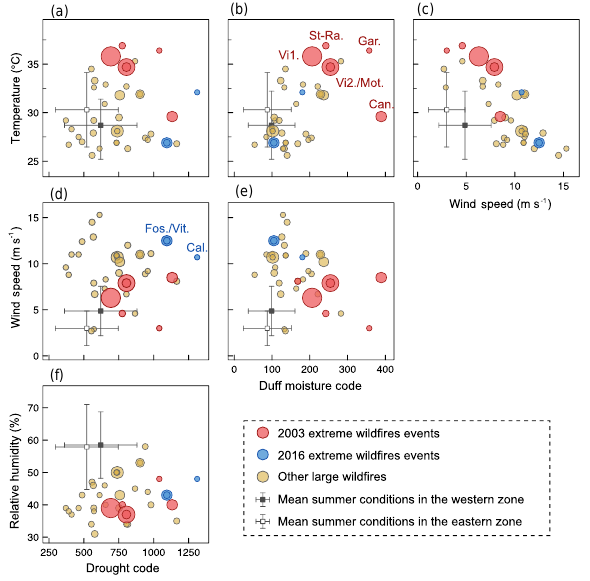
Figure 5. Bivariate plots of the daily weather and drought condi- tions associated with summer large fires that were previously classi- fied into three distinct groups. The size of fire points is proportional to the size of the corresponding fire (min = 250ha; max = 5646ha). The mean and standard deviations of summer weather conditions in each area are also shown. An individual description of the 2003 and 2016 extreme wildfires events can be found in Table 1.